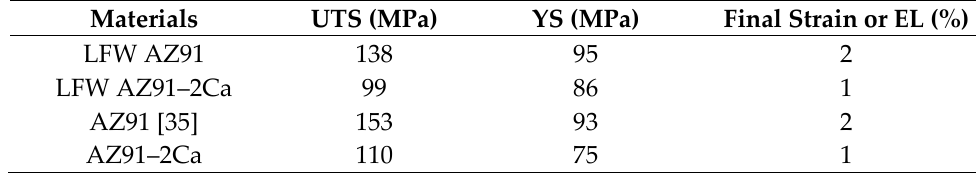
Table 4. Mechanical properties for both cast and welded alloys.